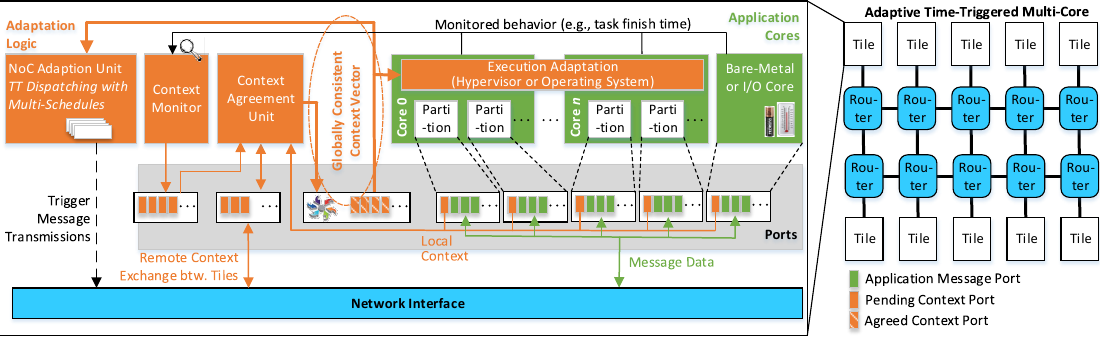
Figure 2. Adaptive time-triggered multi-core